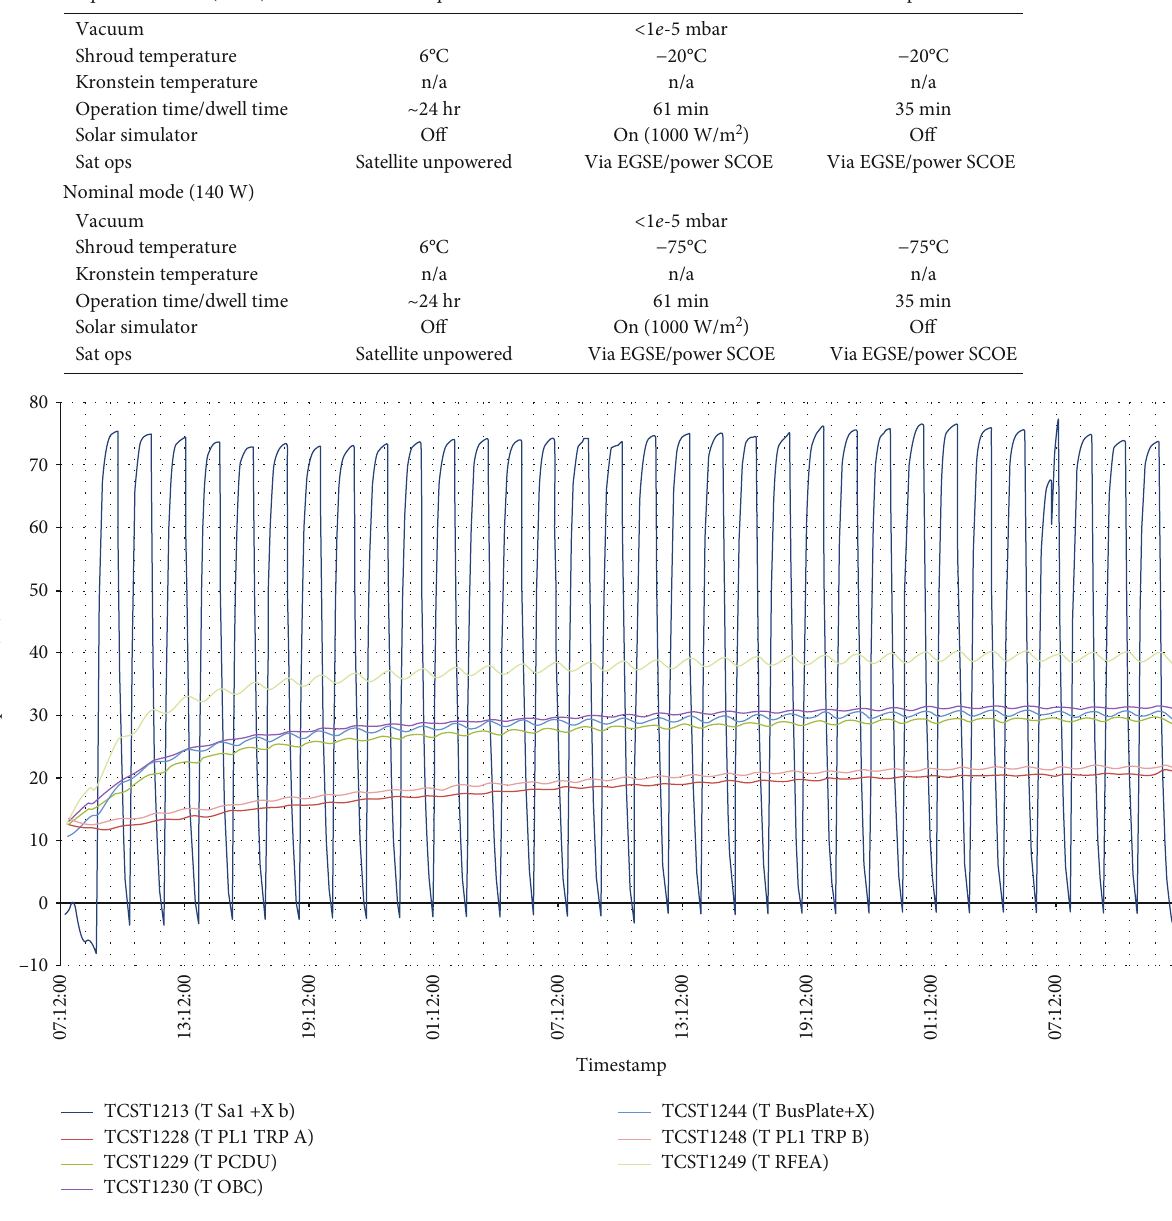
Figure 18: Eu:CROPIS Orbit Simulation Test — setting and result overview (acquisition mode, 48h, and 32